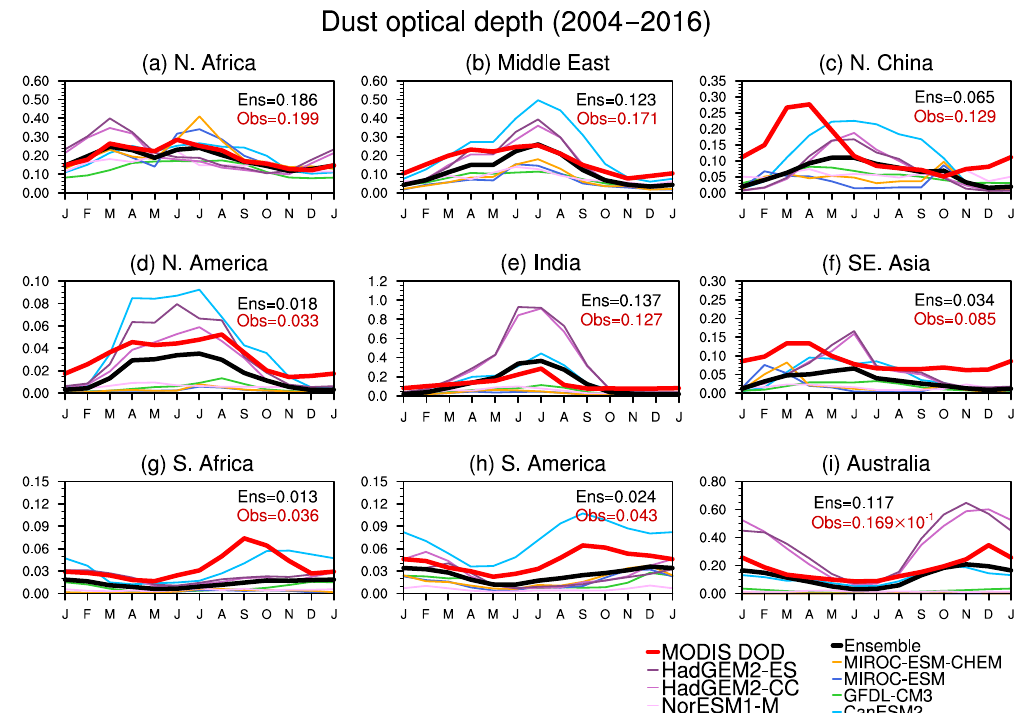
Figure 3. Seasonal cycle of DOD in nine regions (Table 2) averaged over 2004–2016. Thick red lines denote MODIS DOD, thick black lines denote CMIP5 multi-model mean, and other colorful lines denote individual model output. The annual means from MODIS DOD (Obs; red) and multi-model mean (Ens; black) are shown in each panel. Note that in (i) MODIS DOD (red line) is scaled 10 times to better display the season